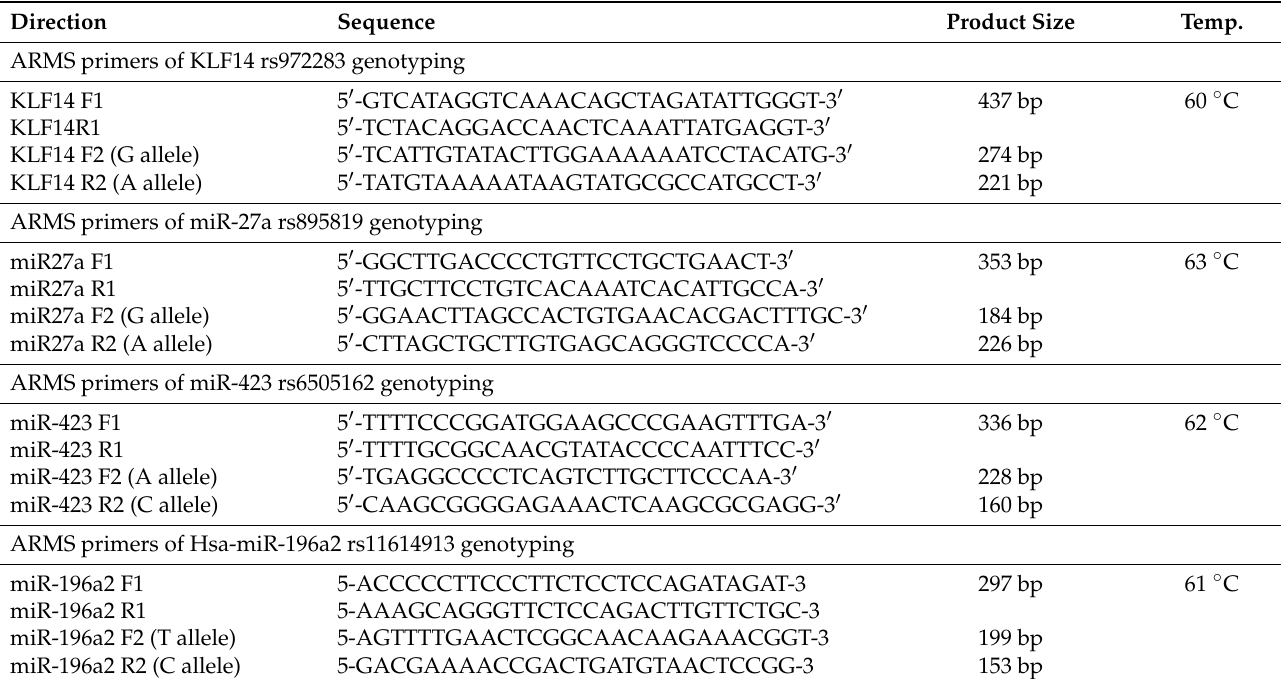
Table 1. ARMS-PCR primers for KLF-14 rs972283, miR-27 rs895819, miR-423-rs6505162, and miR-